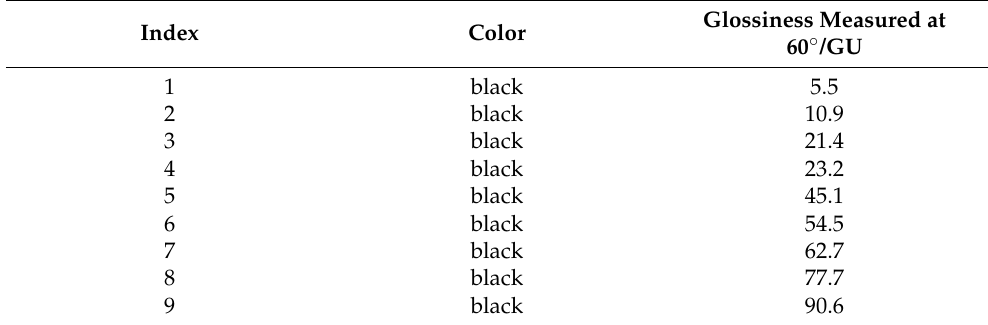
Table 1. The parameters of the stimuli in the Real group.